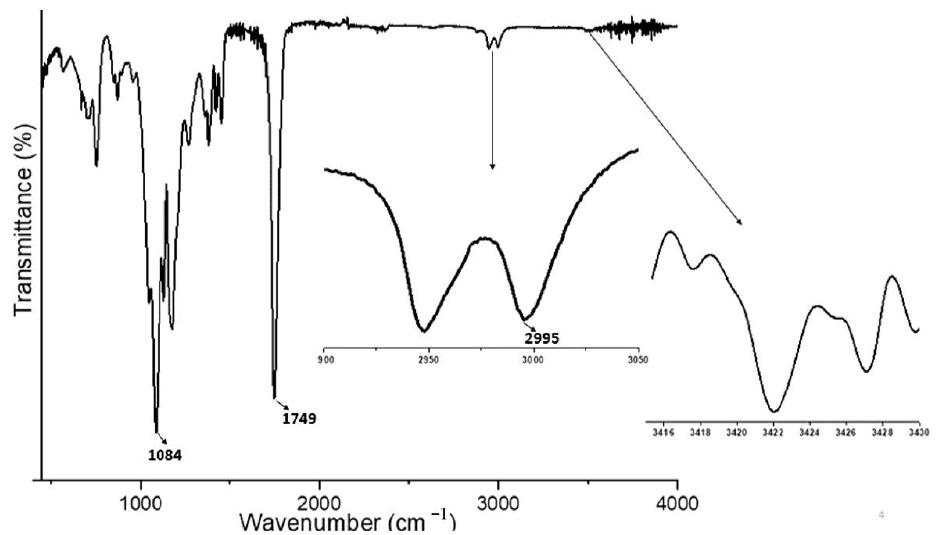
Figure 3. A representative FTIR spectrum for the respective PLGA-CS-PEG microspheres synthesized.